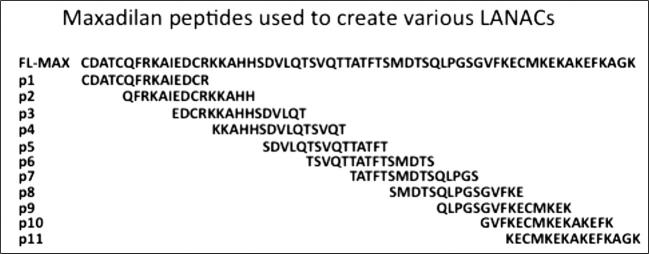
Synthetic MAX peptides used in CLDC formulations. 15-amino acid (AA) peptides were chemically synthesized and used together with the CLDC adjuvant. Each peptide, shown in single-letter code, overlapped their succeeding peptide by 10 AAs and spanned the entire length of the MAX molecule. P11 overlaps P10 by 12 AA.